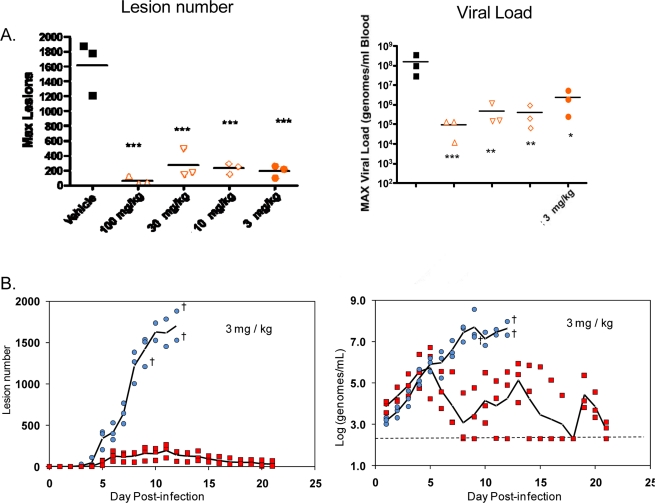
Efficacy of ST-246 in a non-human primate model of monkeypox virus infection. Cynomolgus macaques were infected with 5 × 107 pfu of monkeypox virus via intravenous inoculation. At 3 days post-inoculation, ST-246 was administered by oral gavage once per day for 14 consecutive days. Viral DNA in the blood was determined by quantitative PCR. Viral DNA and lesion counts were measured every day for 21 days (adapted from Jordan et al.) [63]. (A) The maximum viral DNA levels in the blood and lesion number for individual animals over the course of the experiment were plotted per treatment group. The average value (bar) for each treatment group is shown. (B) Daily lesion numbers and viral DNA levels in the blood were shown for vehicle-treated animals (blue circles) and ST-246-treated animals at 3 mg /k g (red squares) with the average values plotted as a single black line. Cross symbols indicate day of death. The dashed horizontal line shows the limit of quantification of viral DNA.